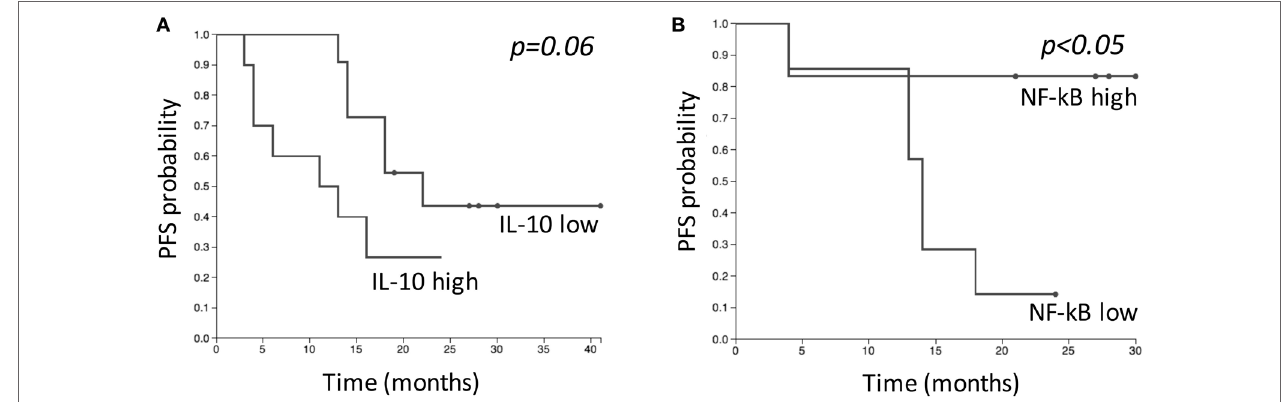
FigUre 7 | Kaplan–Meier estimates comparing progression-free survival (PFS) of patients with “low” and “high” levels of IL-10 (a) , and NF- κ B in natural killer cells (B) before SBRT. “Low” and “high” groups were defined based on median baseline value of each parameter. (a) “Low” group ( n = 11); “high” group ( n = 10). (B) “Low” group ( n = 7); “high” group ( n =